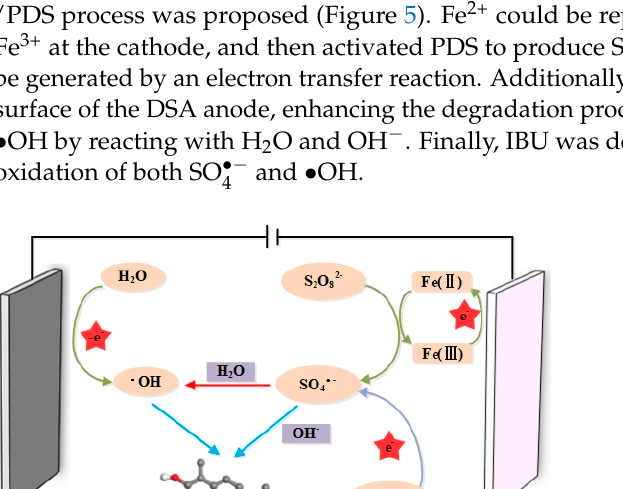
Table 3. Main intermediates for the degradation of IBU in the EC/Fe 3+ /PDS system .